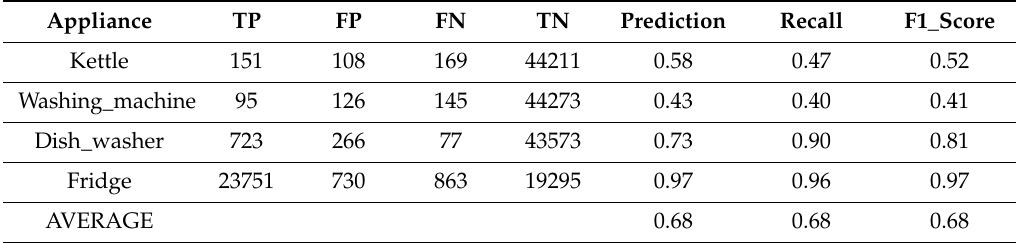
Table 3. Results of the algorithm evaluated on UK-DALE. TP = True positive, FP = False positive, FN = False negative, TN = True